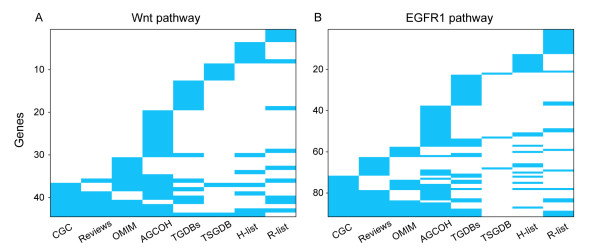
Distribution of cancer genes in the Wnt and EGFR1 pathways. The x axis depicts the eight cancer gene lists and the y axis depicts the overlapping genes between the genes in the eight lists and all the genes in the pathways.